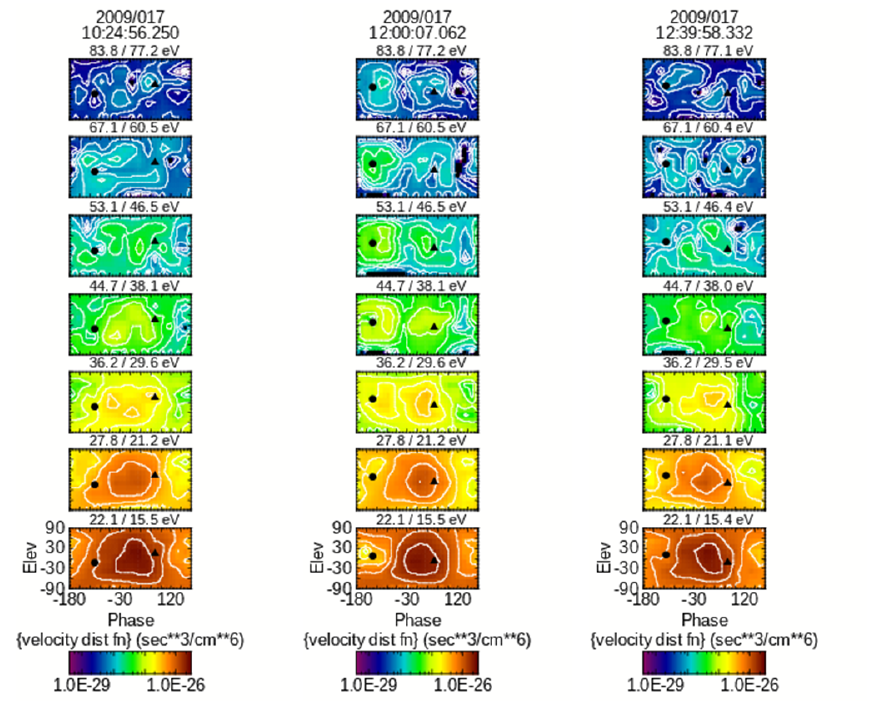
Figure 4. Three sets of φ – θ plots from the event in Figs. 2 and 3. Red arrows in Fig. 3 show the locations of the data in each column of plots. The center column of plots is from a foreshock interval as evidenced by the presence of a return electron